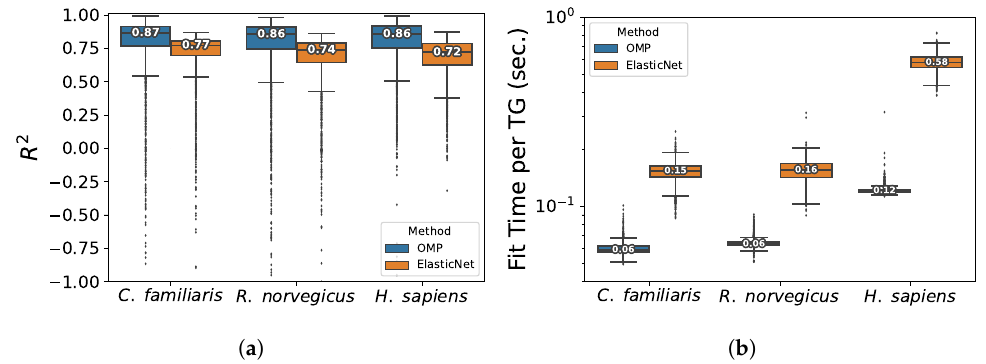
Figure 6. Average R 2 validation determination coefficients and average fitting run-times for